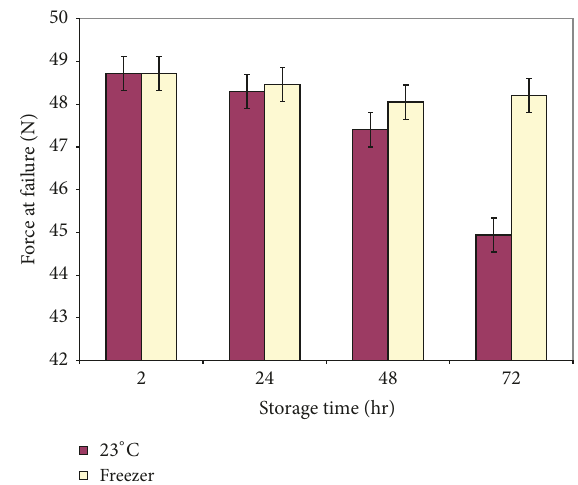
Figure3:Relationshipbetweencompressionforcesat25%compres- sionandstoragetimeat23 ∘ C(roomtemperature)and − 18 ∘ C(freezer temperature) for pita bread (source: 3rd batch).